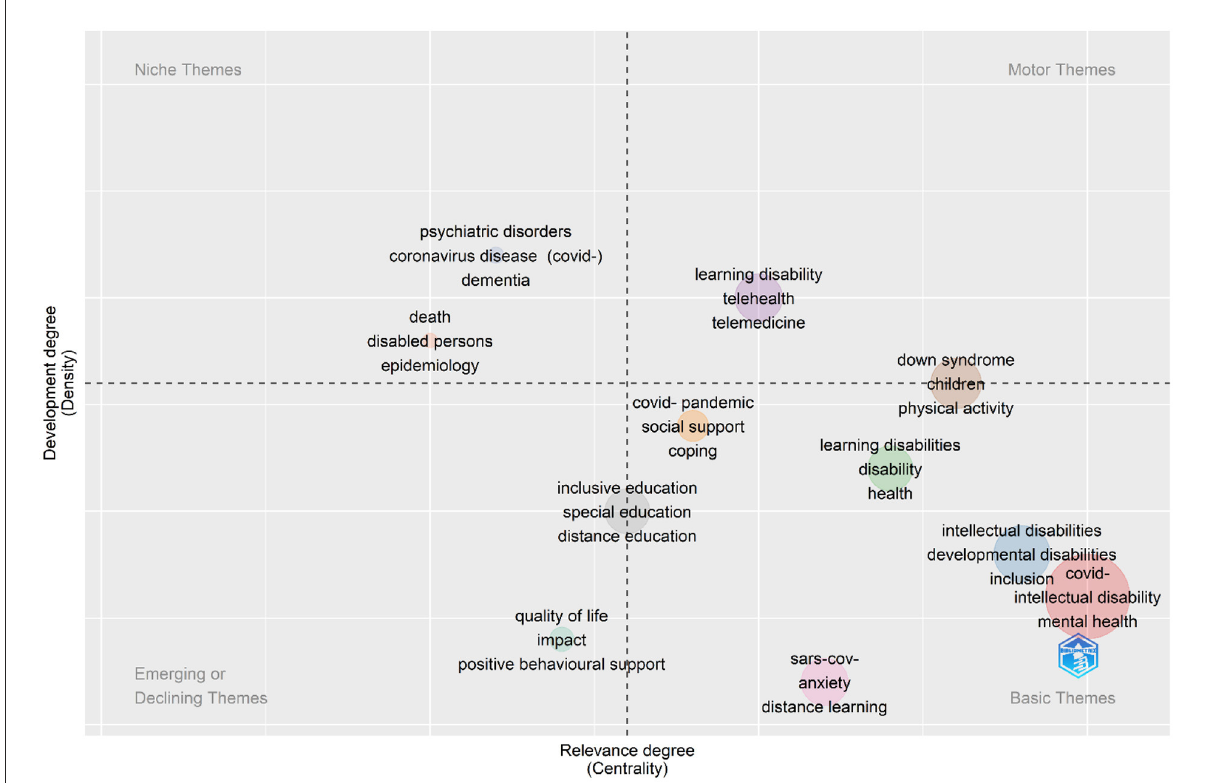
FIGURE4 Thematic map analysis. Upper-right quadrant: motor themes—high density (developed) and high centrality (relevant); upper-left quadrant: niche themes—high density (developed) and low centrality (less relevant); lower-left quadrant: emerging or declining themes—low density (less developed) and low centrality (less relevant); lower-right quadrant: basic themes—low density (less developed) and high centrality